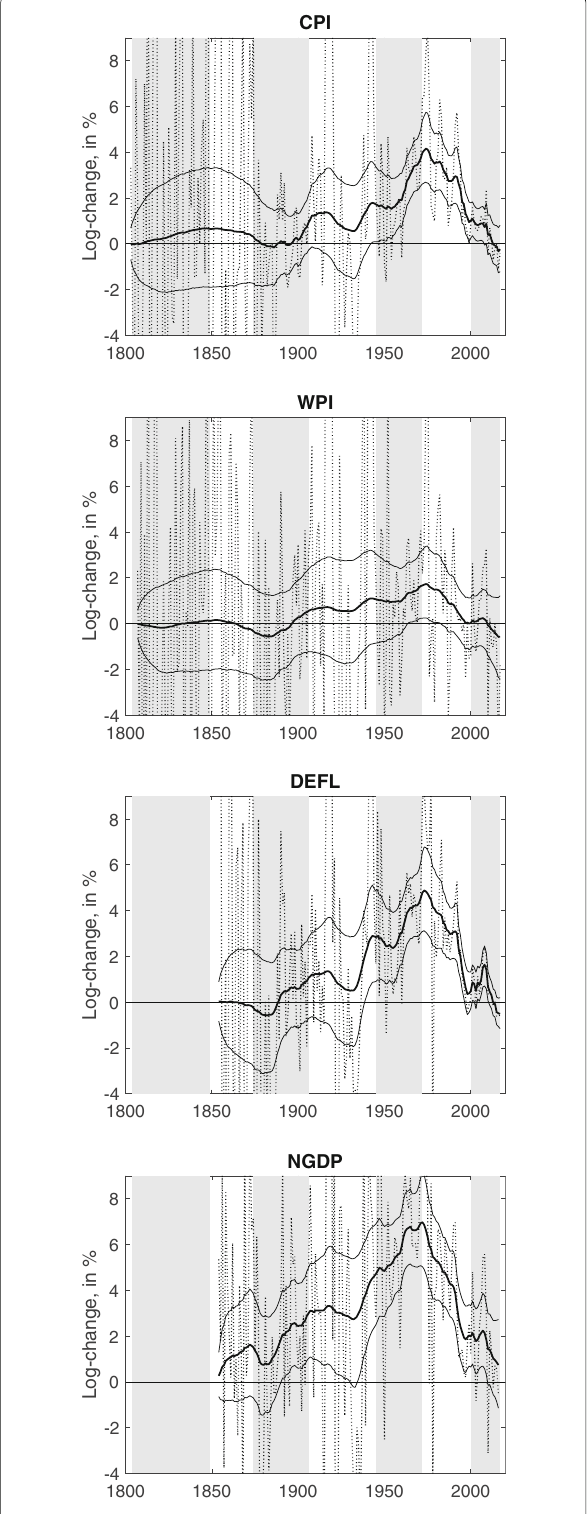
Fig. 2 Permanent component. Estimated permanent component (mean, 5th percentile, 95th percentile) and actual data (dashed line). The shaded and unshaded areas represent various monetary